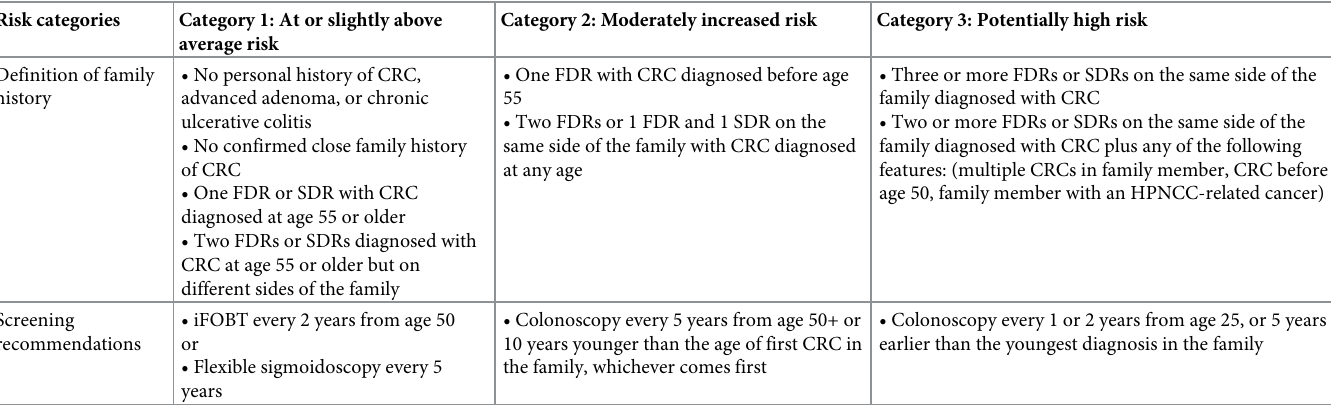
Table 1. NHMRC CRC familial risk categories and screening recommendations